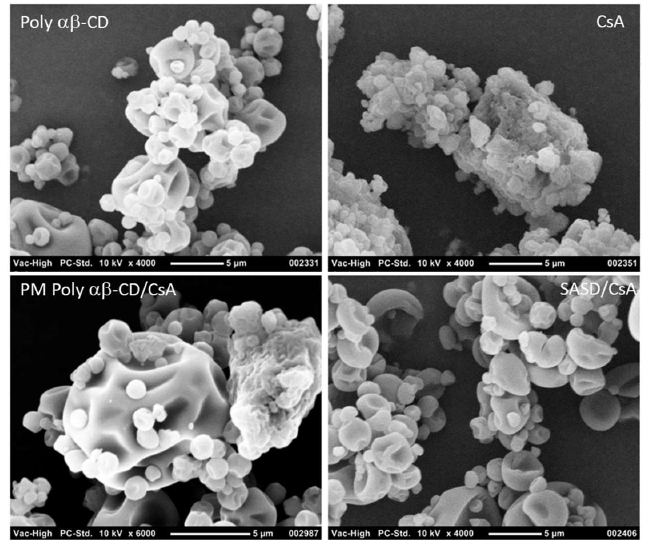
Figure 1. SEM micrographs from Poly-α -CD copolymer (top left), crystalline cyclosporine (CsA; top right), physical mixture of Poly-α -CD/CsA (bottom left), and spherical amorphous solid dispersion based on Poly-α -CD copolymer of CsA (SASD/CsA; bottom right).